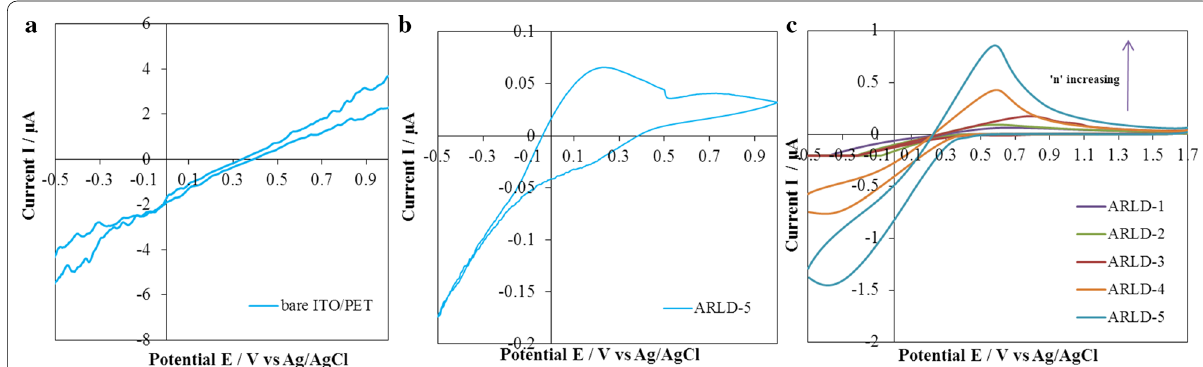
Fig. 6 The cyclic voltammograms of a bare ITO/PET in 0.1 M KCl in deionized water, b ARLD-5 electrode in 0.1 M KCl in deionized water, c prepared electrodes in (0.1 M KCl in deionized water) including 15 μM Al 3